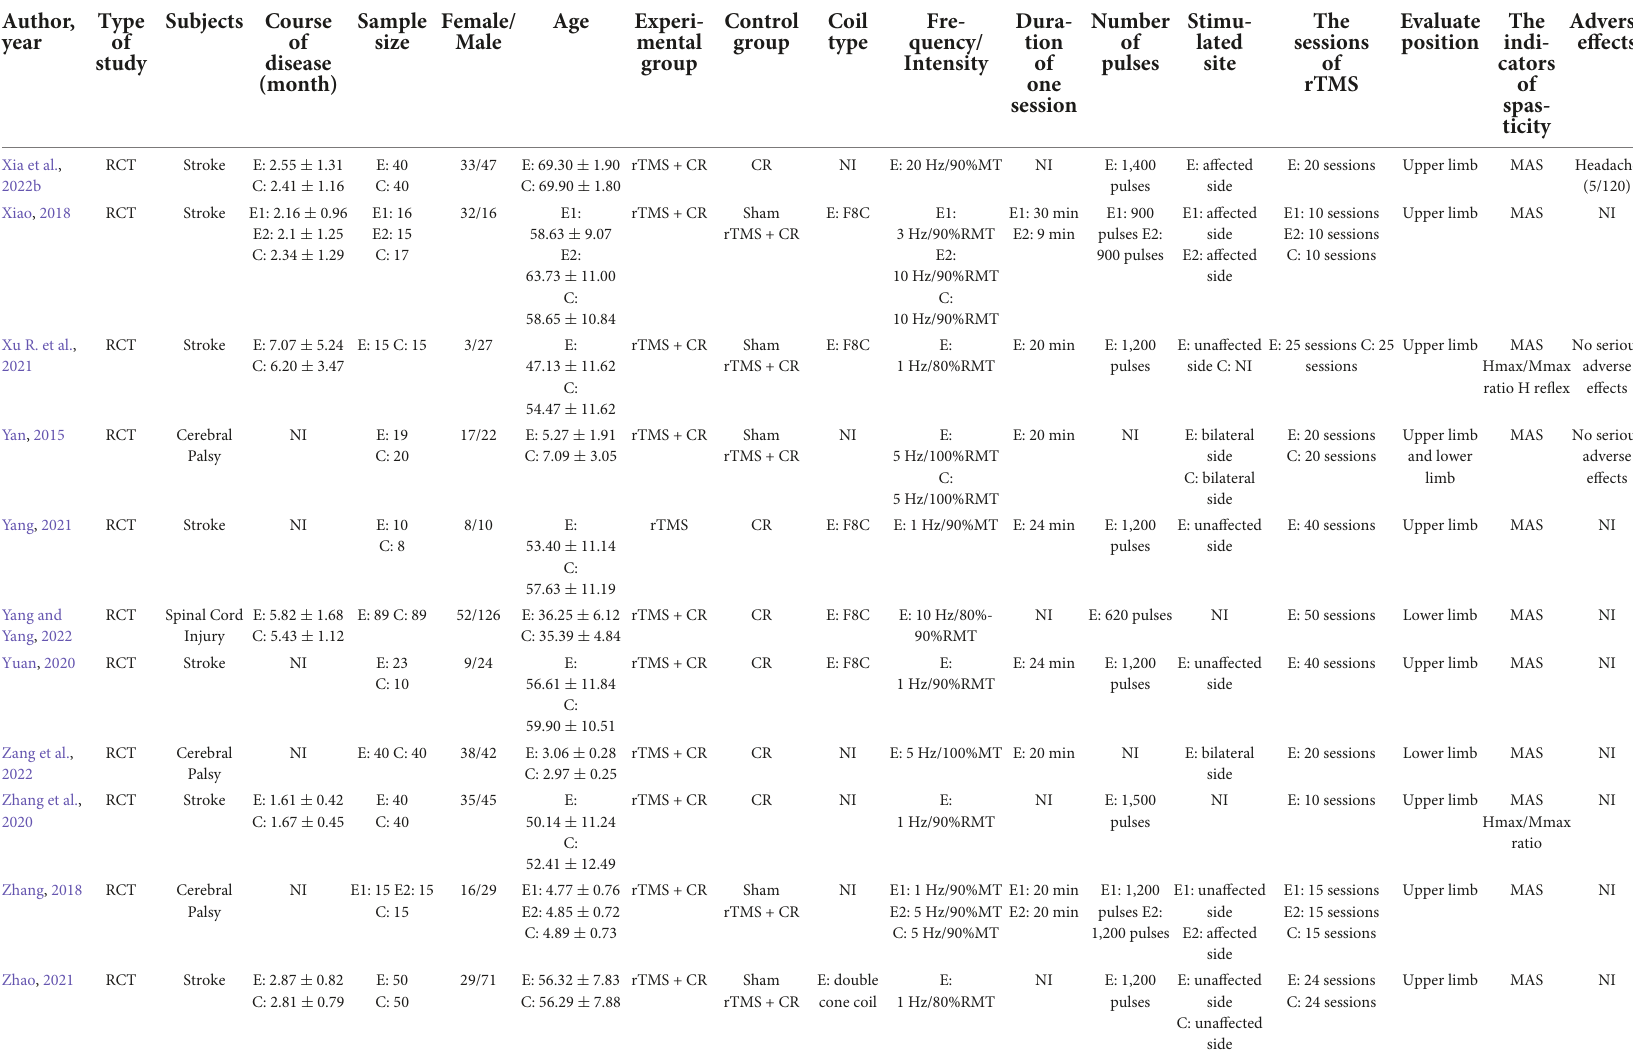
RCT, randomized controlled trial; E1, low-frequency rTMS group; E2, high-frequency rTMS group; E3, low-frequency rTMS plus high-frequency rTMS group; C, control group; E, experimental group; rTMS, repetitive transcranial magnetic stimulation;